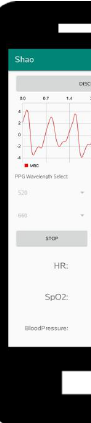
Figure 5. Light source specs and configuration. ( a ) ( b ) Figure 6. Reflection spectrum: ( a ) on a standard reflection white plate; ( b )on a finger.